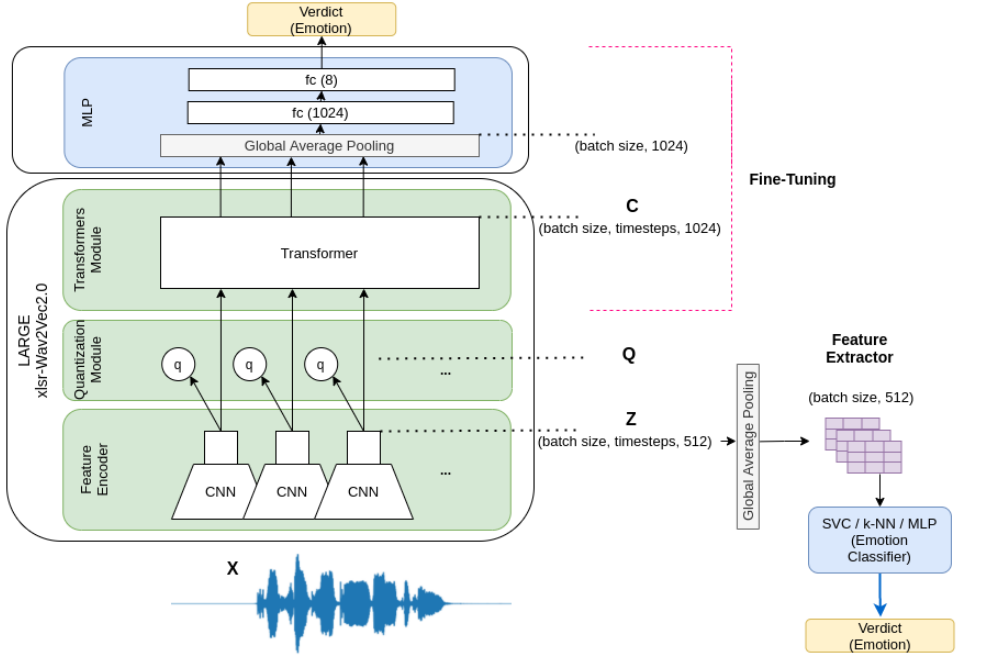
Figure 2. Proposed pipelines for speech emotion